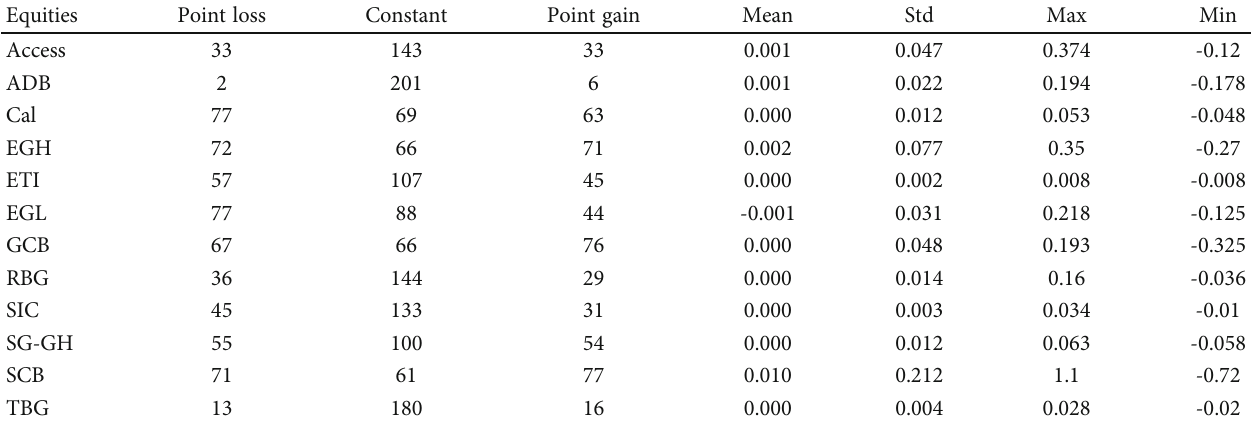
Table 1: Summary statistics for the number of weekly price averages and stock transition change.